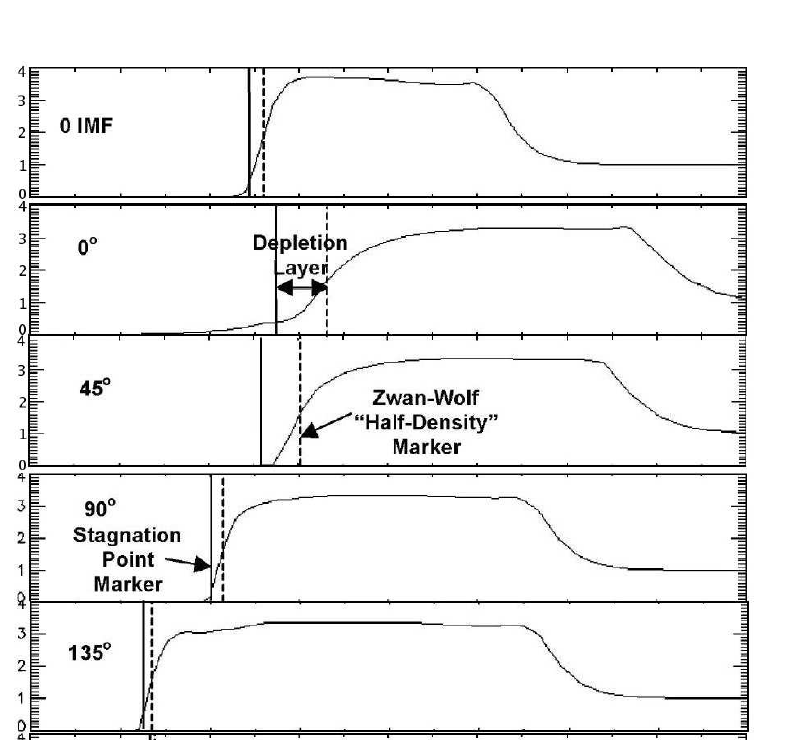
Fig. 10. The flow speed, the plasma density, the magnetic field magnitude, and the N/B ratio along the Sun-Earth line in Fig. 9. The other formats of this figure are the same as those in Fig. 4.